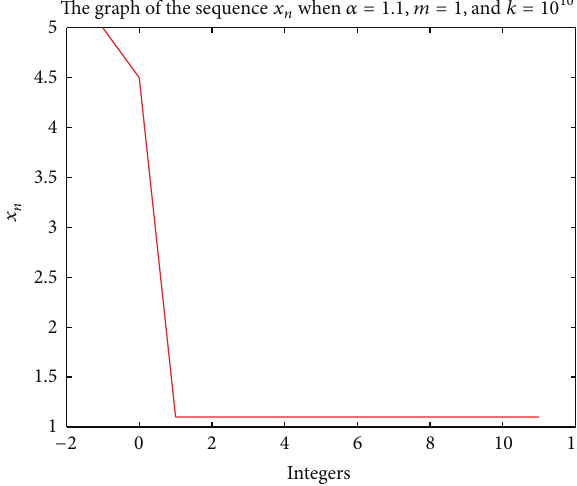
Figure 5: When 𝛼 > 1 and 𝑘 → ∞ the positive solution converges to 𝛼 , which gives a counter example of Theorem 2.1-(b) and the results that followed in [5]. Here 𝛼 = 1.1 , 𝑚 = 1 , and 𝑘 = 10 10